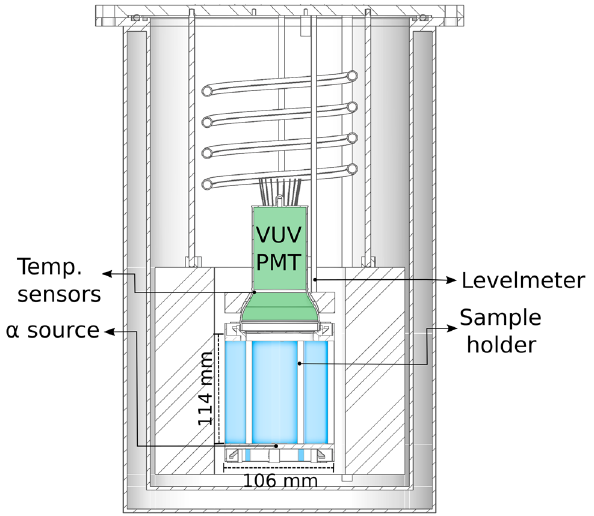
Fig. 8 Schematic cut of the LAr setup with its main components indi- cated